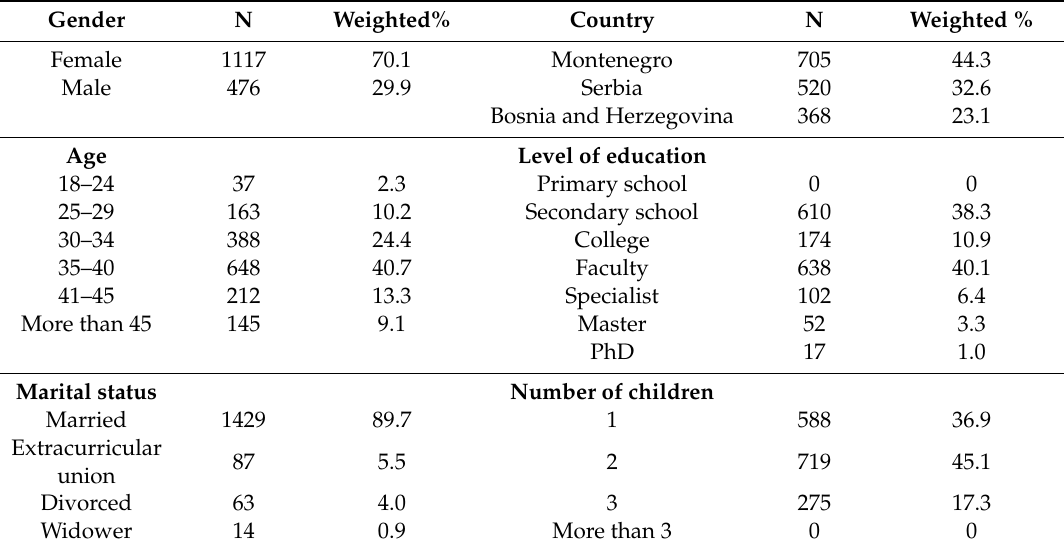
Table 1. Characteristics of respondents.